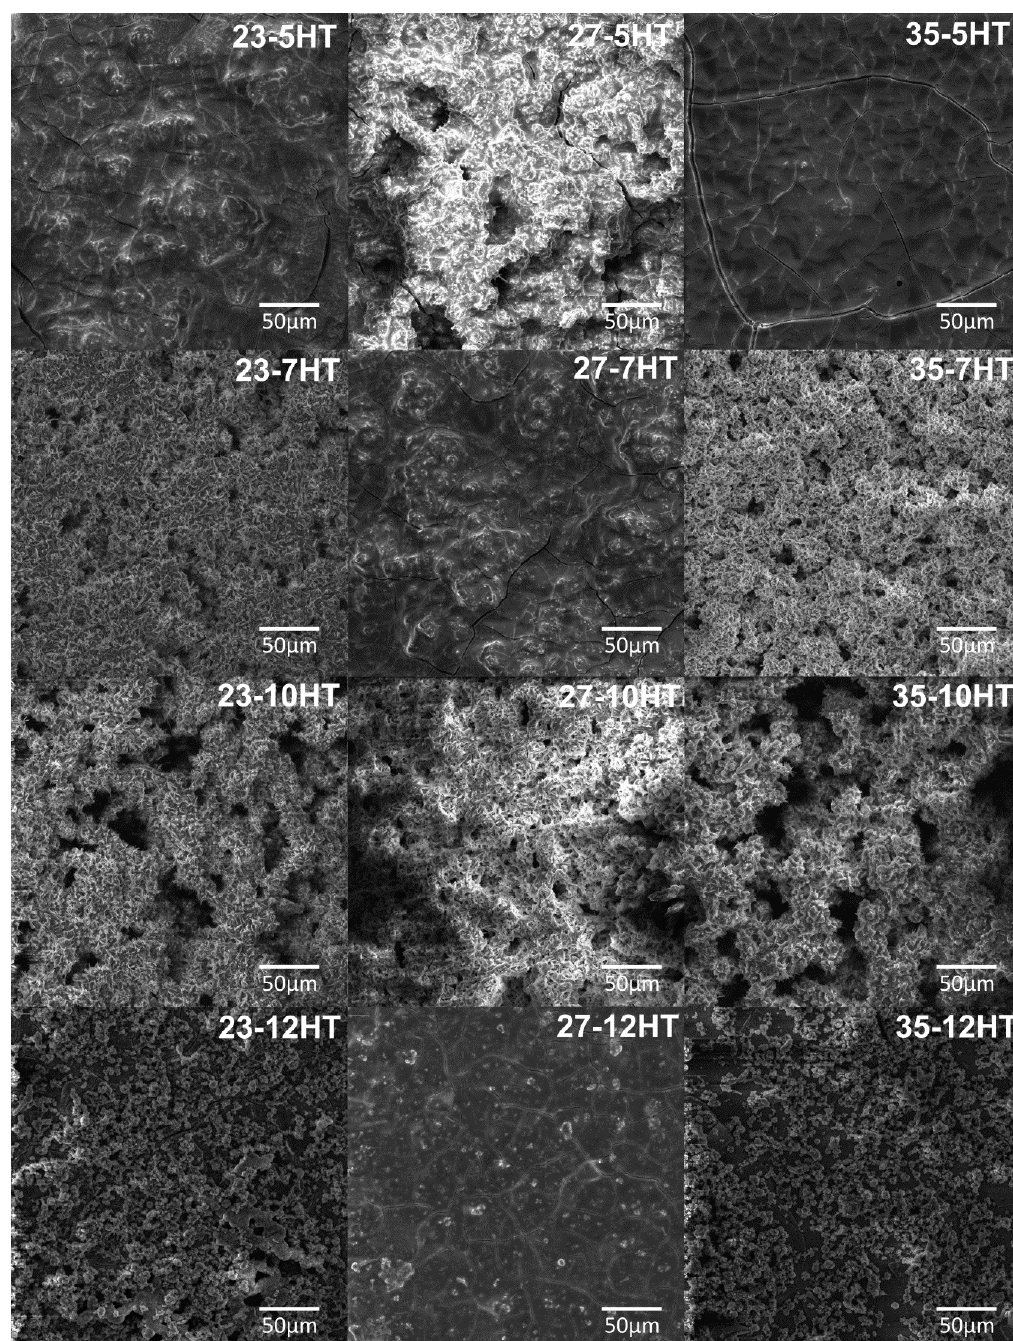
Figure 13. SEM microphotographs of Ti23Mo, Ti27Mo, Ti35Mo, after acid etching, alkaline treatment in various molar concentrations of NaOH, and hydrothermal treatment.